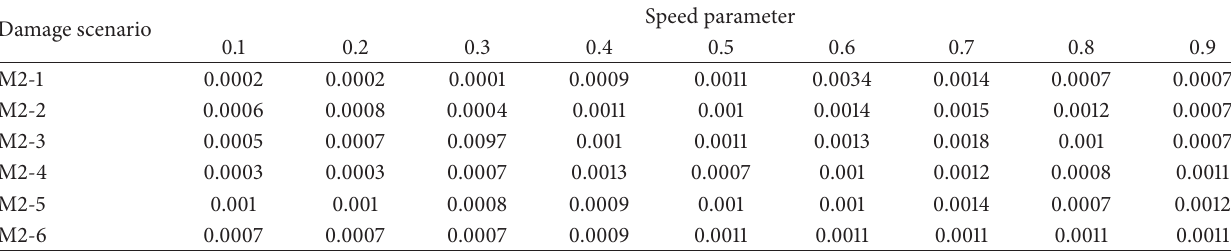
Table 7: RPE of ADM method for model